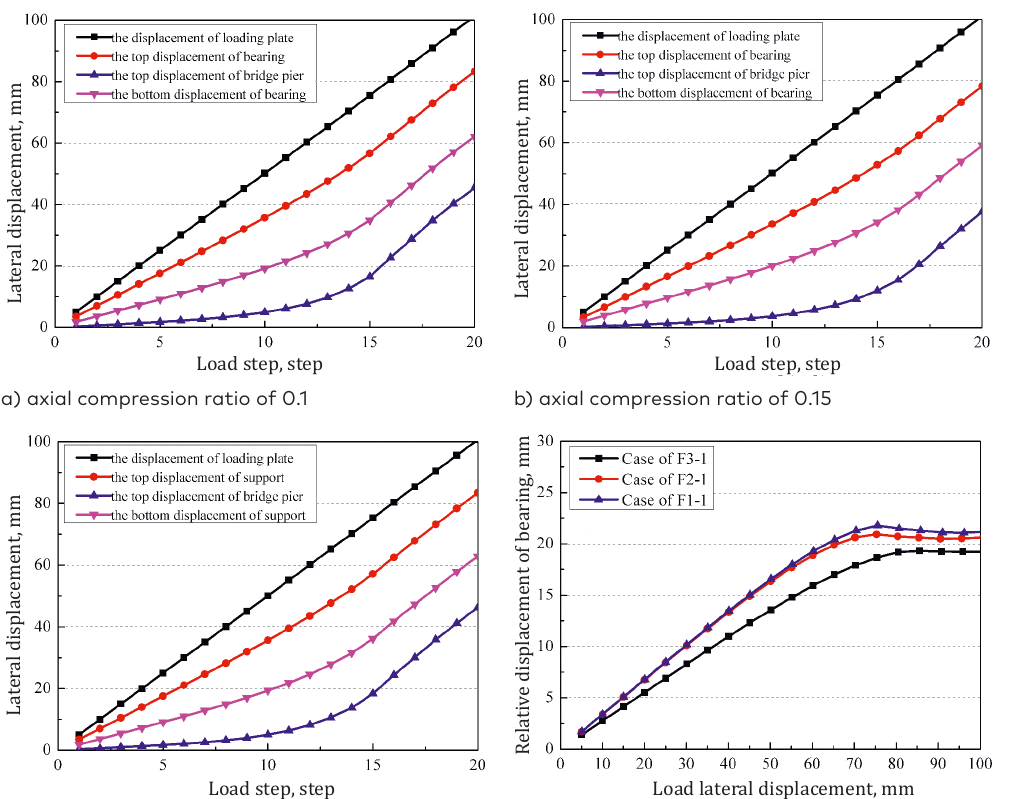
c) axial compression ratio of Figure 4. Lateral displacement of the series system with friction coefficient of 0.2 at both ends of the bearing